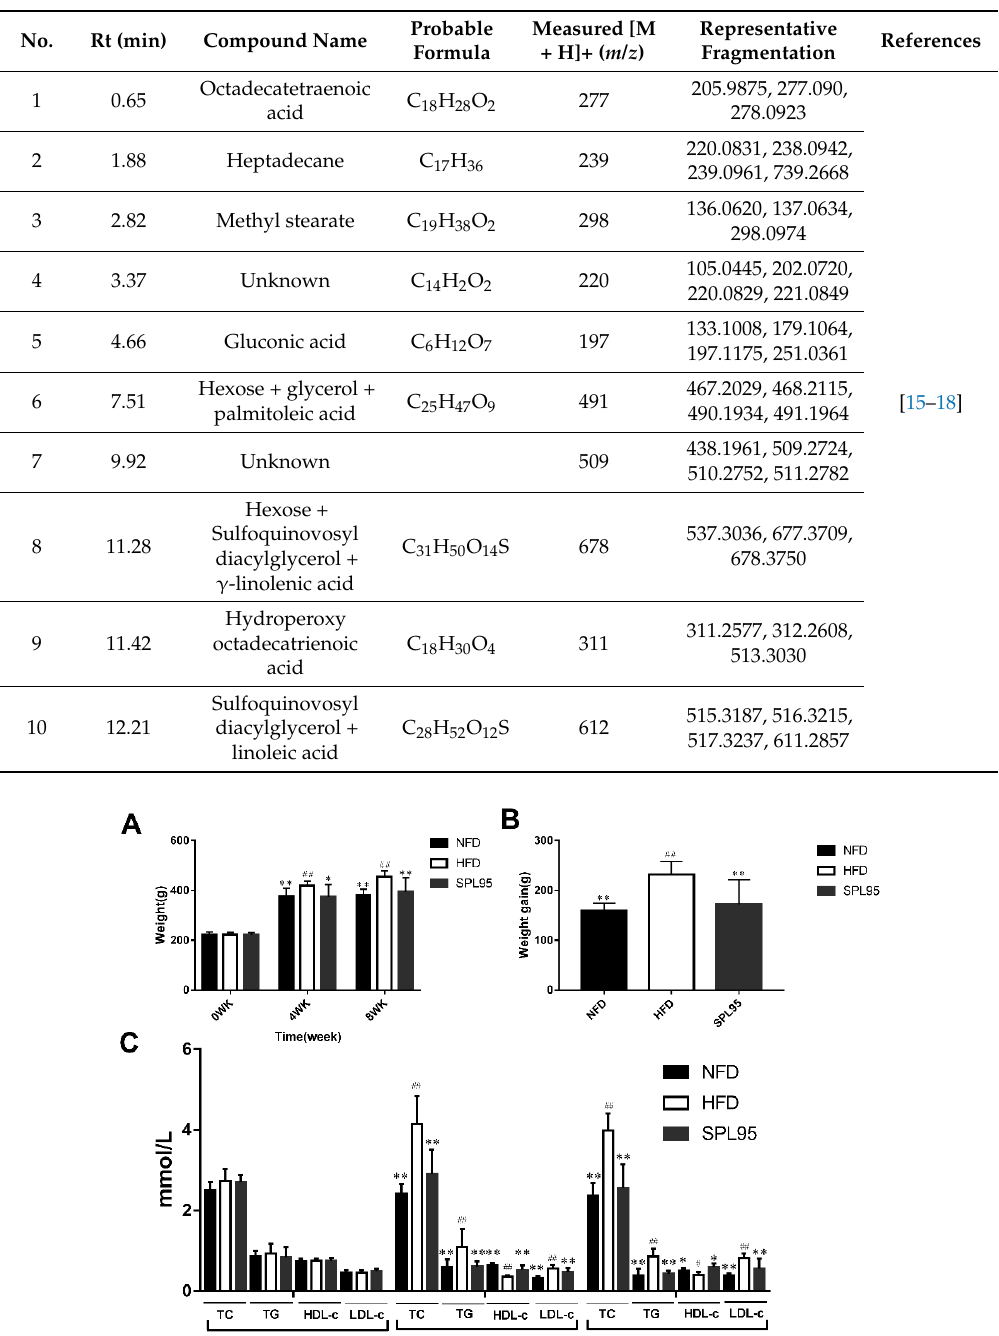
Table 1. Characterization of probable major metabolites of ethanol extract from Spirulina platensis by UPLC/Q–TOF–MS.